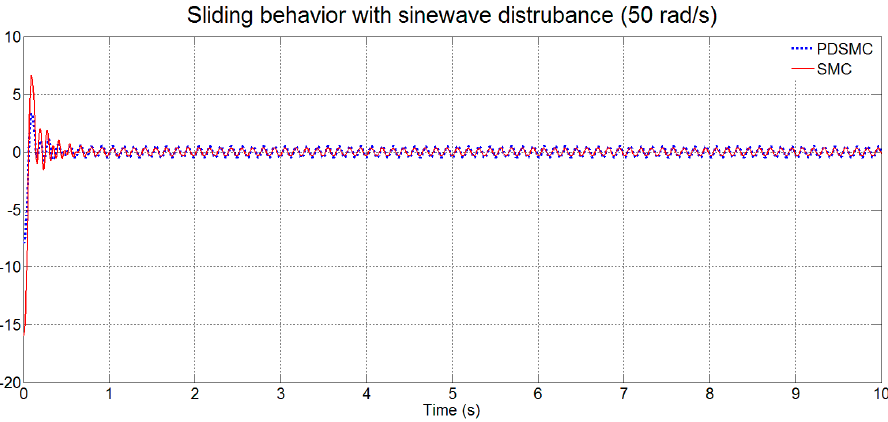
Figure 9. Effect of disturbance on sliding surface.